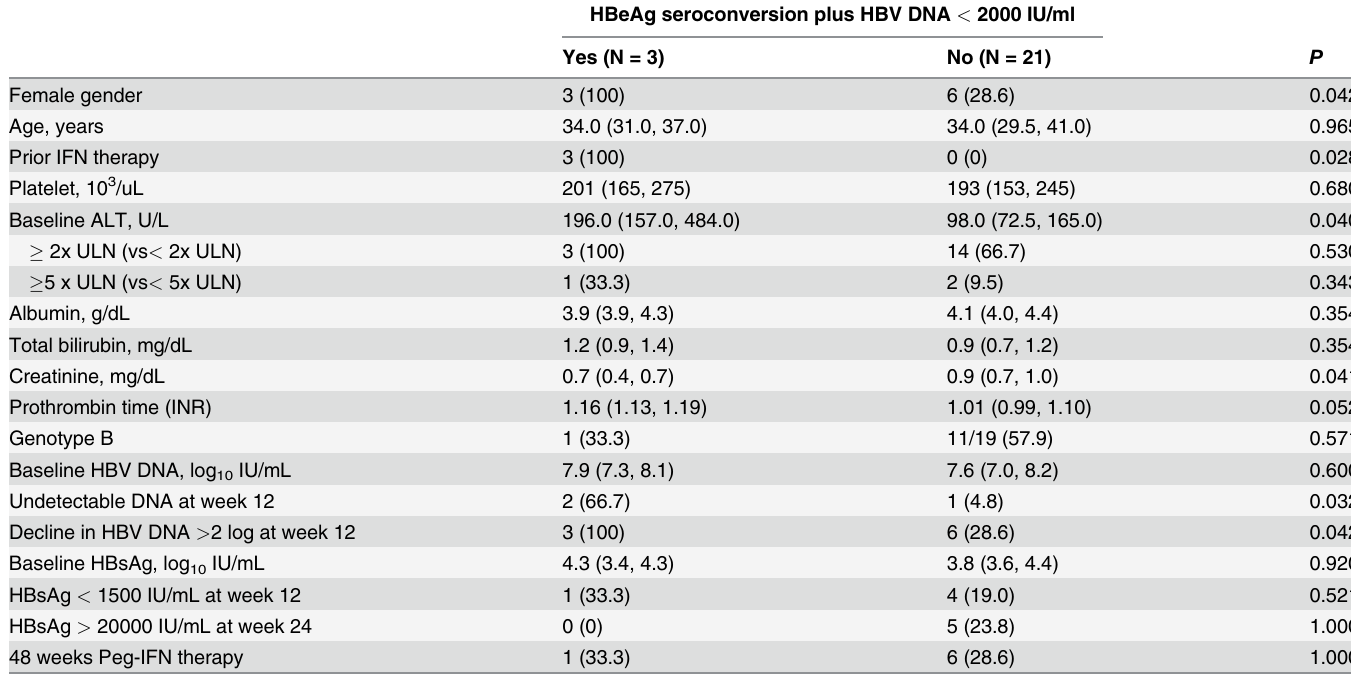
Table 2. Factors associated with HBeAg seroconversion plus HBV DNA < 2000 IU/mL 12 months post-treatment in treatment experienced HBeAg- positive CHB